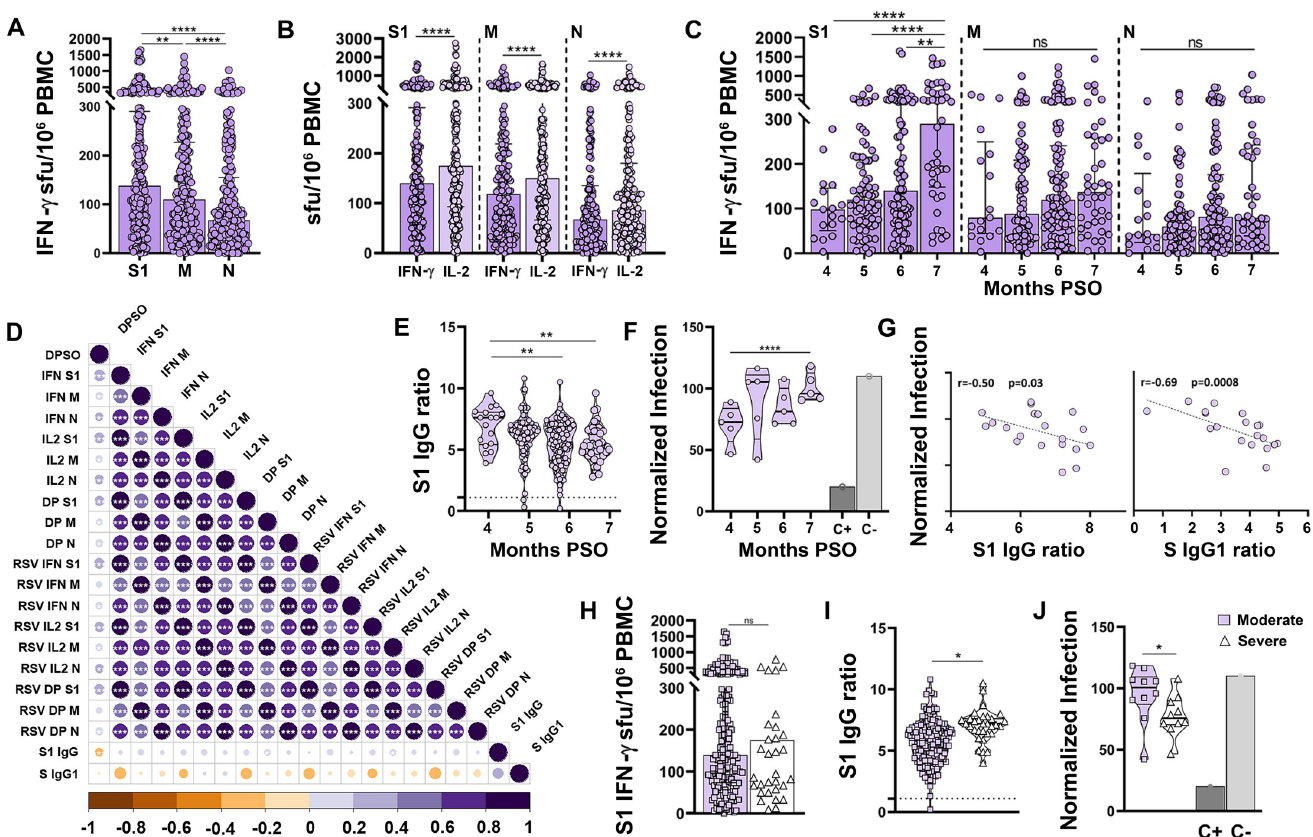
Fig 6. Duration of SARS-CoV-2-specific cellular and humoral immunity after natural infection. ( A ) S1, M and N cellular responses in recovered patients. ( B ) Comparison between IFN- γ and IL-2-producing T-cell responses. ( C ) IFN- γ -producing T-cell responses according to the months post-symptom onset (PSO). ( D ) Correlation matrix of cellular and humoral immune variables analyzed. Only significant correlations (p < 0.05) are represented with asterisks. ( E ) SARS-CoV-2 S1 IgG according to the months PSO. Dashed line represents the established cut-off of positivity (ratio � 1.1). ( F ) Neutralizing capacity represented as normalized infection according to the months PSO. ( G ) Correlation between neutralizing capacity and the semi-quantitative results of SARS-CoV-2 IgG ELISA (left) and anti- Spike IgG1 measured by flow cytometry. ( H-J ) S1 IFN- γ -producing T-cells (H), semi-quantitative results of SARS-CoV-2 S1 IgG (I) and neutralizing capacity (J) in recovered patients who suffered a moderate or severe acute disease. Linear regressions were performed using Spearman’s rank test. Horizontal bars and whiskers represent median values and interquartile ranges, respectively. The significance between groups was determined using Mann Whitney or Kruskal-Wallis tests, � p < 0.05, �� p < 0.01, ��� p < 0.001, ���� p < 0.0001. RSV: Relative Spot Volume; DP: IFN- γ /IL-2 double positive